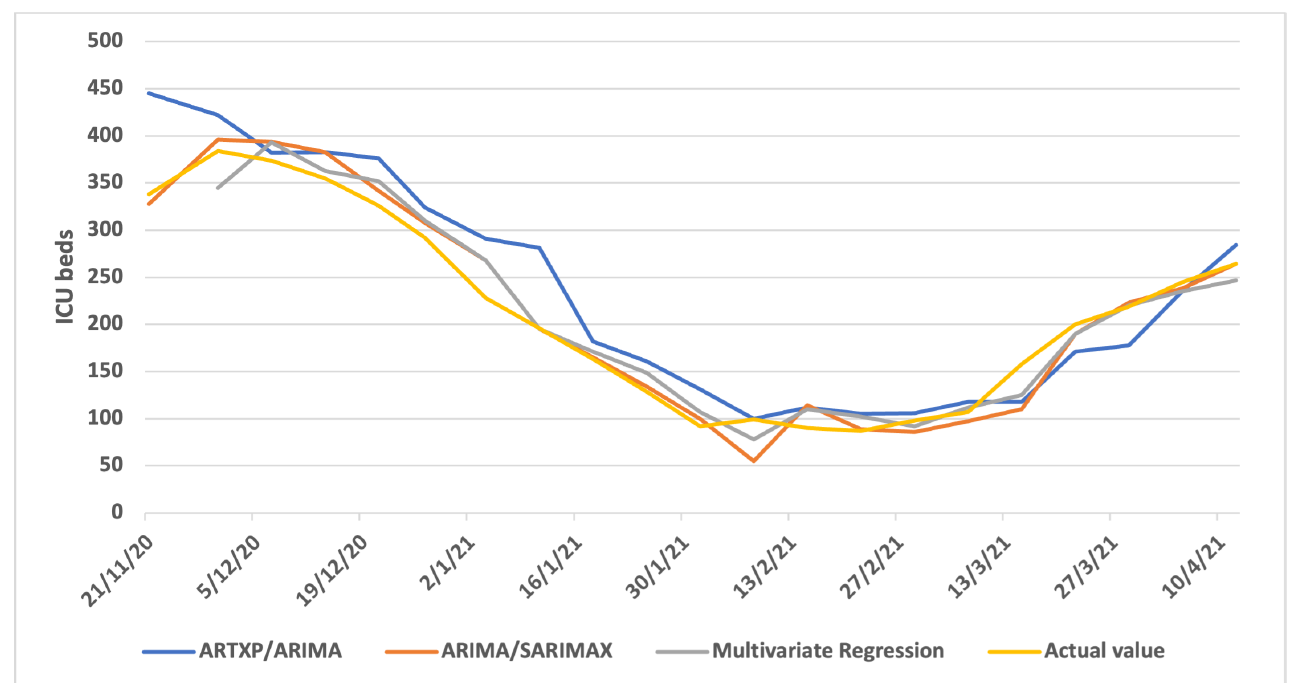
Figure A3. Three weeks Predicted vs. Actual ICUs—Thessaloniki. Figure A4 (one week ahead), Figure A5 (two weeks ahead) and Figure A6 (three weeks ahead) showcase the results per model (ARTXP/ARIMA, ARIMA/SARIMAX and Multivariate Regression) of Predicted vs. Actual ICUs for the Northern Greece area.